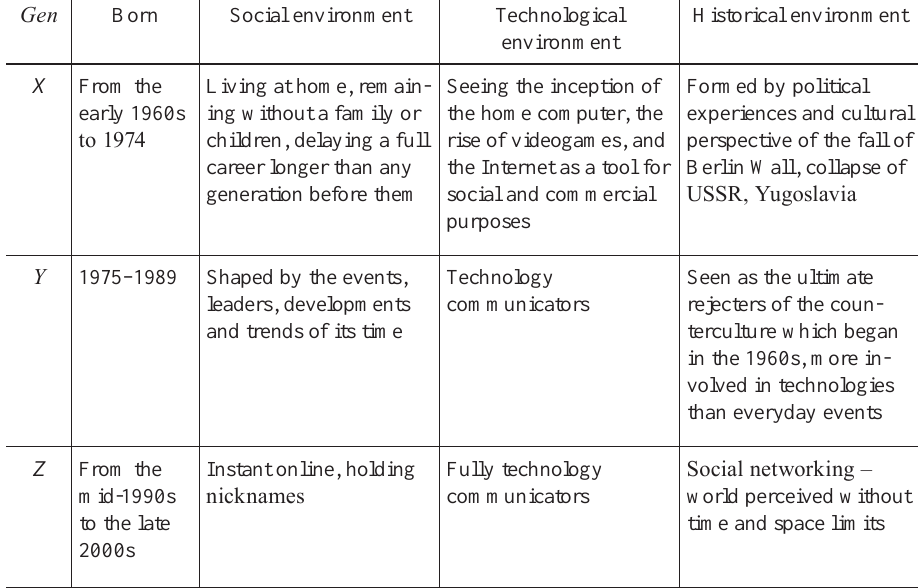
Table 1. Categories of Gen X , Y and Z regimentation